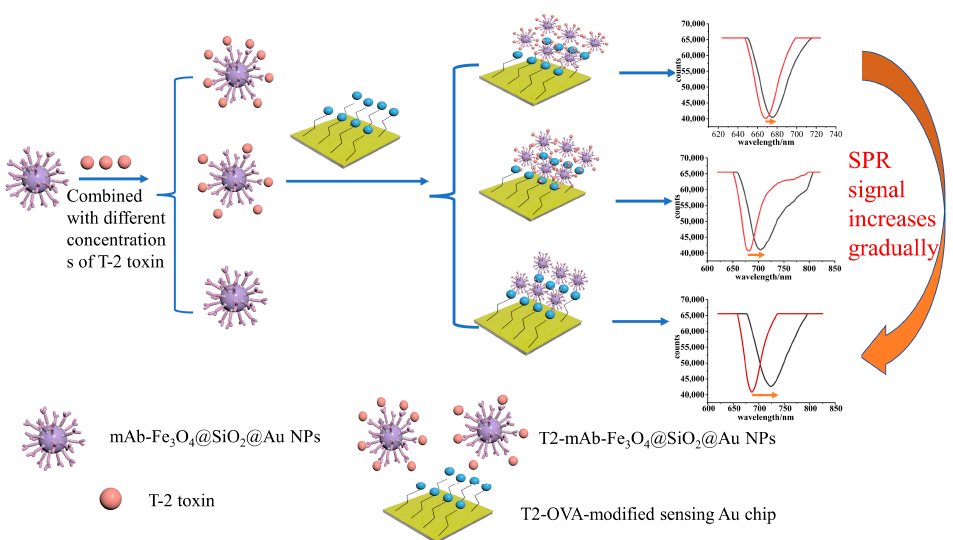
Figure 2. A schematic diagram of the experimental procedure of detecting T-2 toxin based on Fe 3 O 4 @SiO 2 @Au nanoparticle amplification SPR